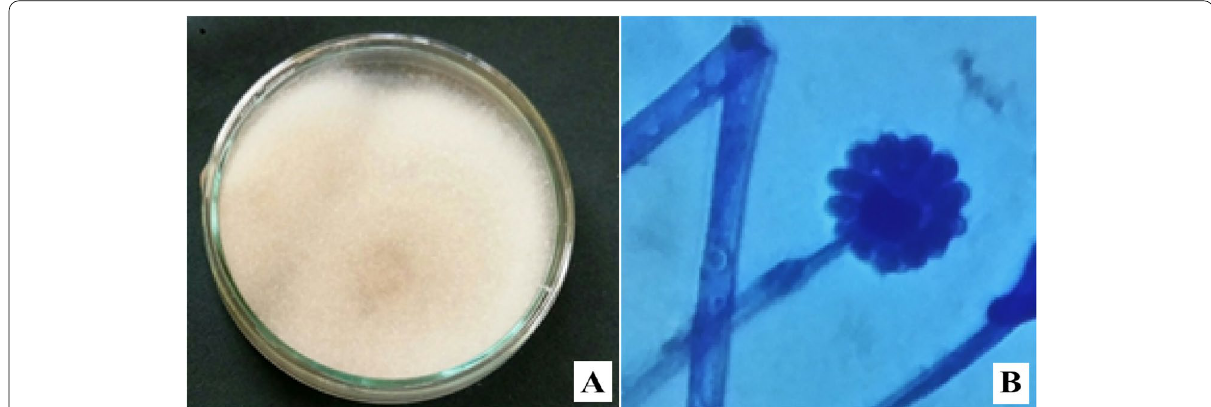
Fig. 1 Morphological characteristics of G. butleri . A Mycelial proliferation on PDA medium. B Hyphae and sporangia (under 40